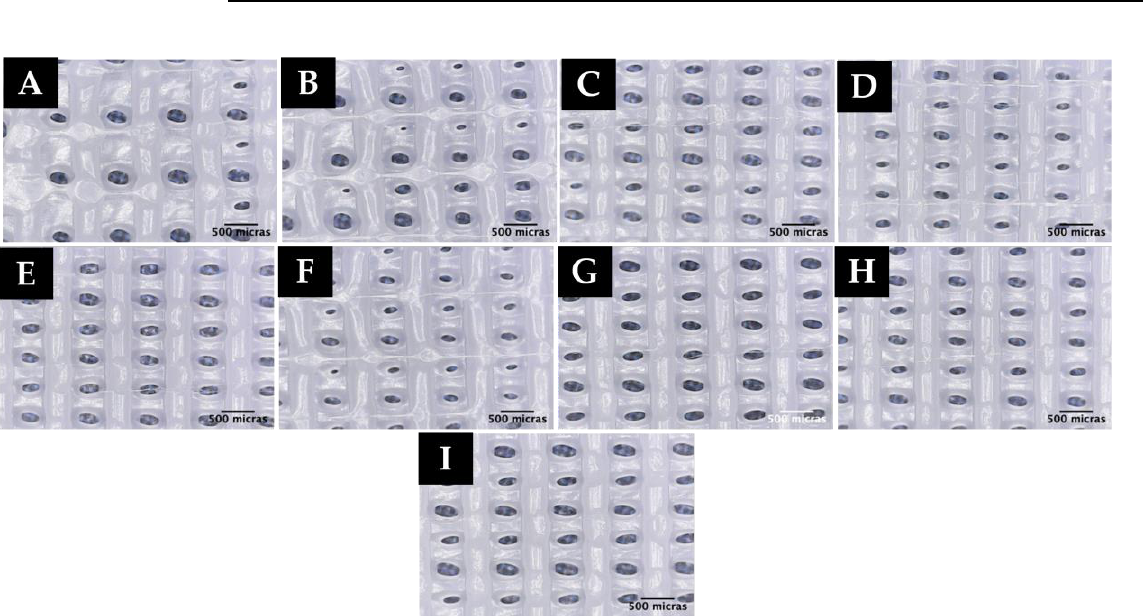
Figure 9. Microscopic image of experiments: ( A ) P1B, ( B ) P2B, ( C ) P3B, ( D ) P4B, ( E ) P5B, ( F ) P6B, ( G ) P7B, ( H ) P8B, ( I ) P9B. ( G ) P7B, ( H ) P8B, ( I )